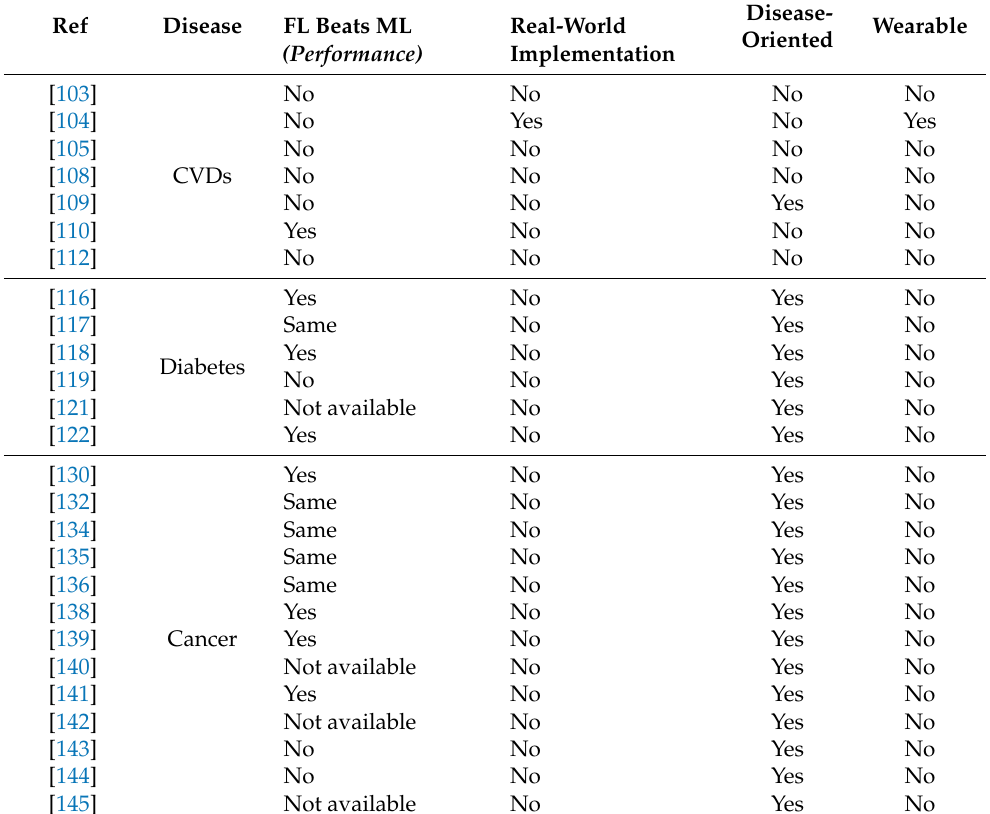
Table 7. Federated machine learning implementations in CVDs